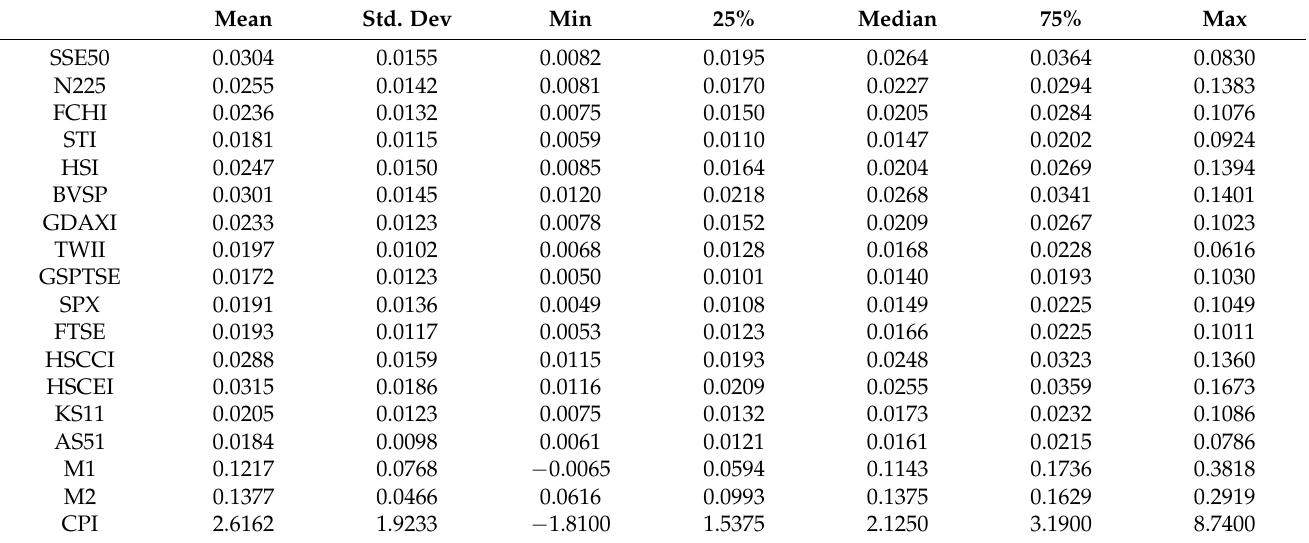
Table 1. Descriptive